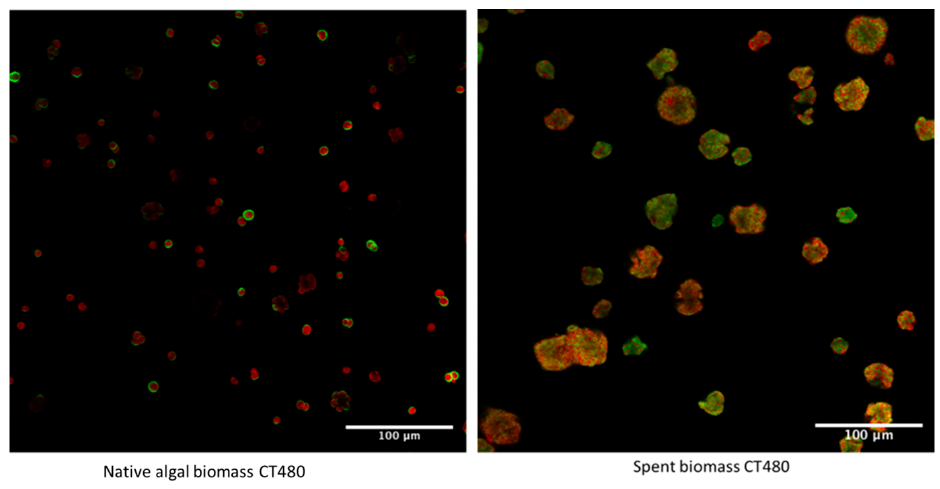
Figure 5. Confocal Laser Microscopy image of initial native and spent biomass mixed with Carbotrace 480.